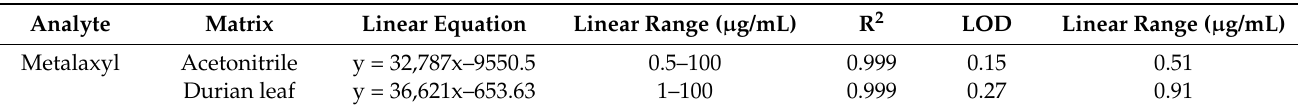
Table 1. Linear equation, correlation coefficient (R 2 ), LOD, and LOQ of metalaxyl (0.5–100 µ g/mL) in acetonitrile solvent and spiked leaf sample.